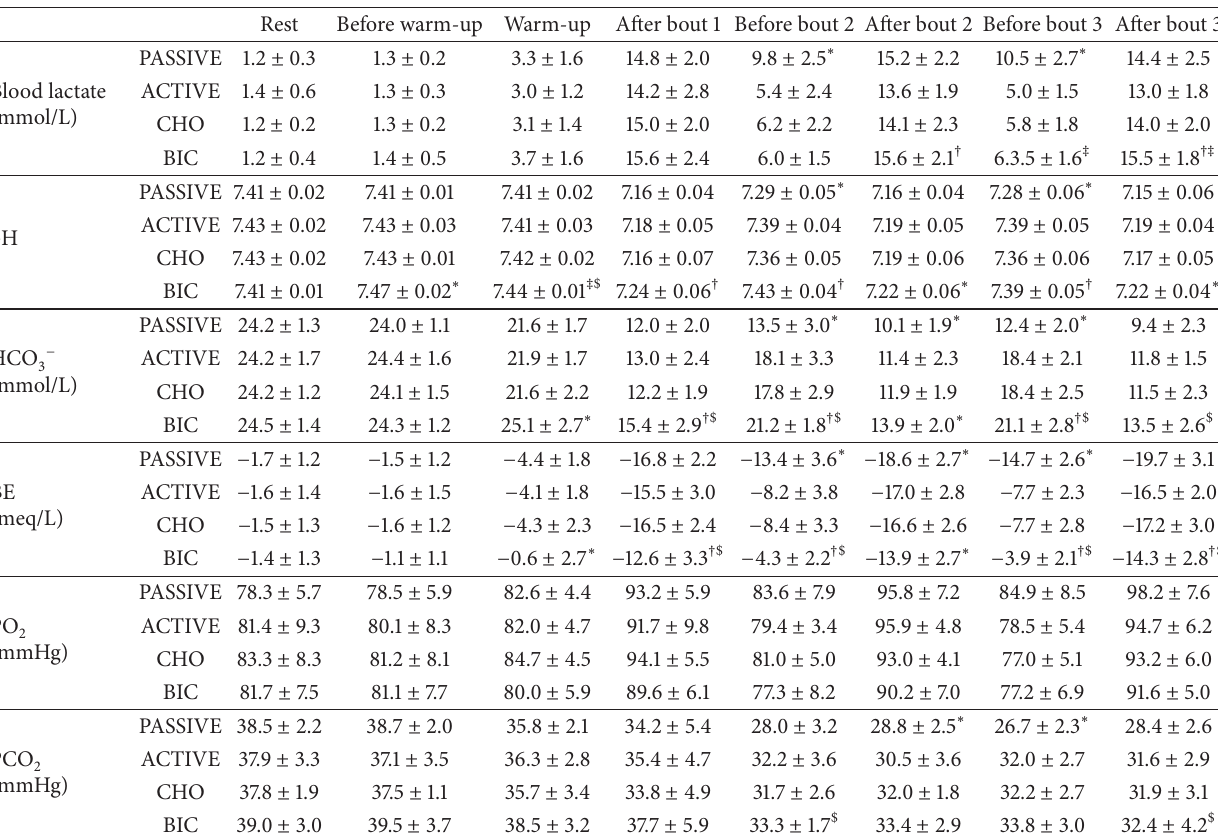
Table 1: Blood lactate, blood gases, pH, and base excess (BE) associated with four interventions at rest, pre-warm-up, post-warm-up, and before and after the three high intensity bouts (mean ±